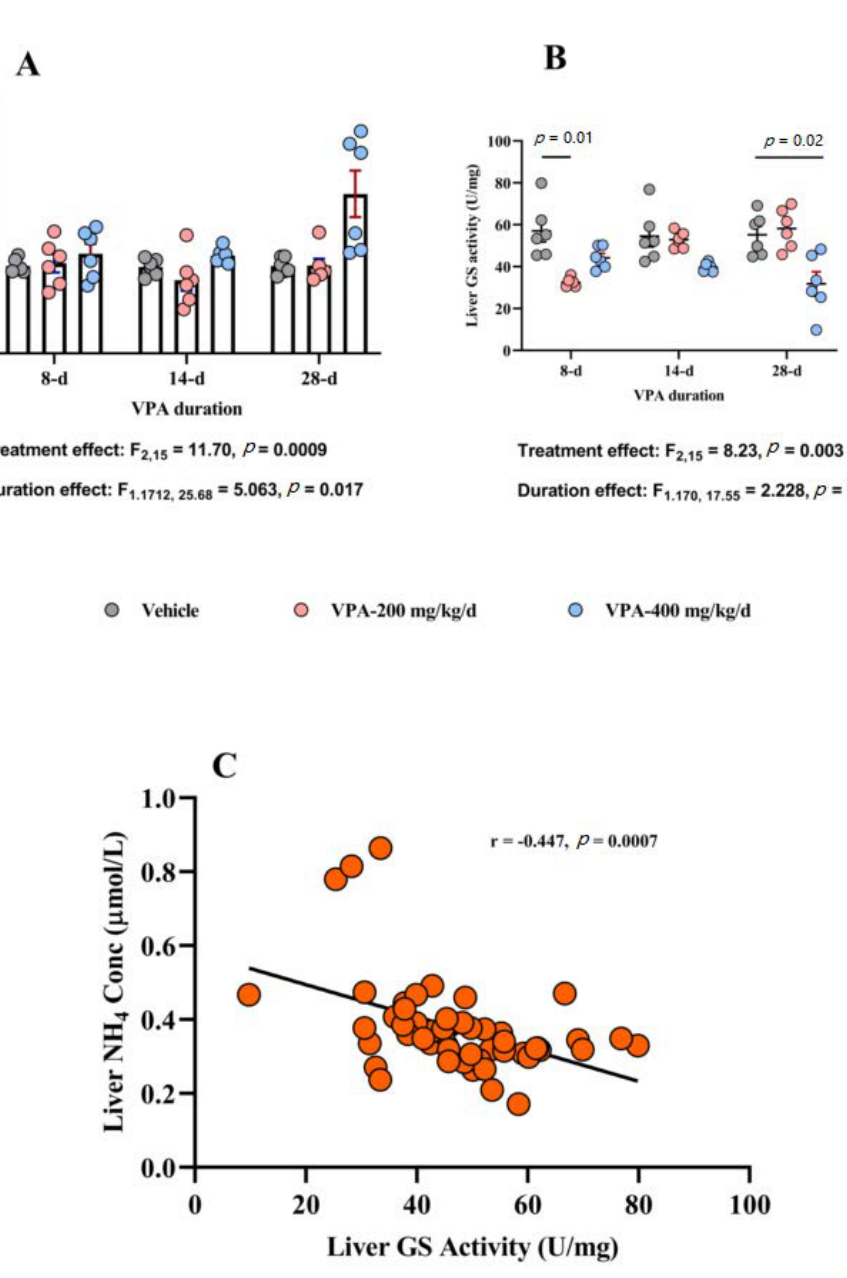
Figure 2. The e ff ect of VPA on liver ammonia (NH 4 ) concentration and glutamine synthetase (GS) enzyme activity. ( A ) VPA treatment (F 2,15 = 11.70, p = 0.0009) and duration (F 1.712,25.68 = 5.063, p = 0.017) have significant e ff ects on liver NH 4 by two-way ANOVA ( n = 6 / group). However, no significant di ff erences were observed at any of the three time points between vehicle and VPA 200 or 400 mg / kg / d. Only a trend toward significance ( p = 0.07) was found at 14 days for the 200 mg / kg / d group (vs. vehicle) and at 28 days for both 200 mg / kg / d group (vs. vehicle, p = 0.059) and also the 400 mg / kg / d group (vs. vehicle, p = 0.059) by Tukey’s multiple comparisons test. ( B ) Only VPA treatment had significant e ff ect on liver GS activity: F 2,15 = 8.23, p = 0.003 by two-way ANOVA ( n = 6 / group). Significant di ff erences were observed at 8 d of treatment between vehicle and VPA 200 mg / kg / d (mean di ff erence, 95% CI, p value: 24.56, 7.610 to 41.51, p = 0.011) and at 14 d of treatment between vehicle and VPA 400 mg / kg / d (mean di ff erence, 95% CI, p value: 13.26, 8.062 to 18.45, p = 0.0003) and at 28 d of treatment between vehicle and VPA 400 mg / kg / d (mean di ff erence, 95% CI, p value: 23.46, 3.780 to 43.14, p = 0.02) by Tukey’s multiple comparisons test. ( C ) Significant negative correlation was found between liver NH 4 concentration and liver GS activity: r = − 0.447, p =